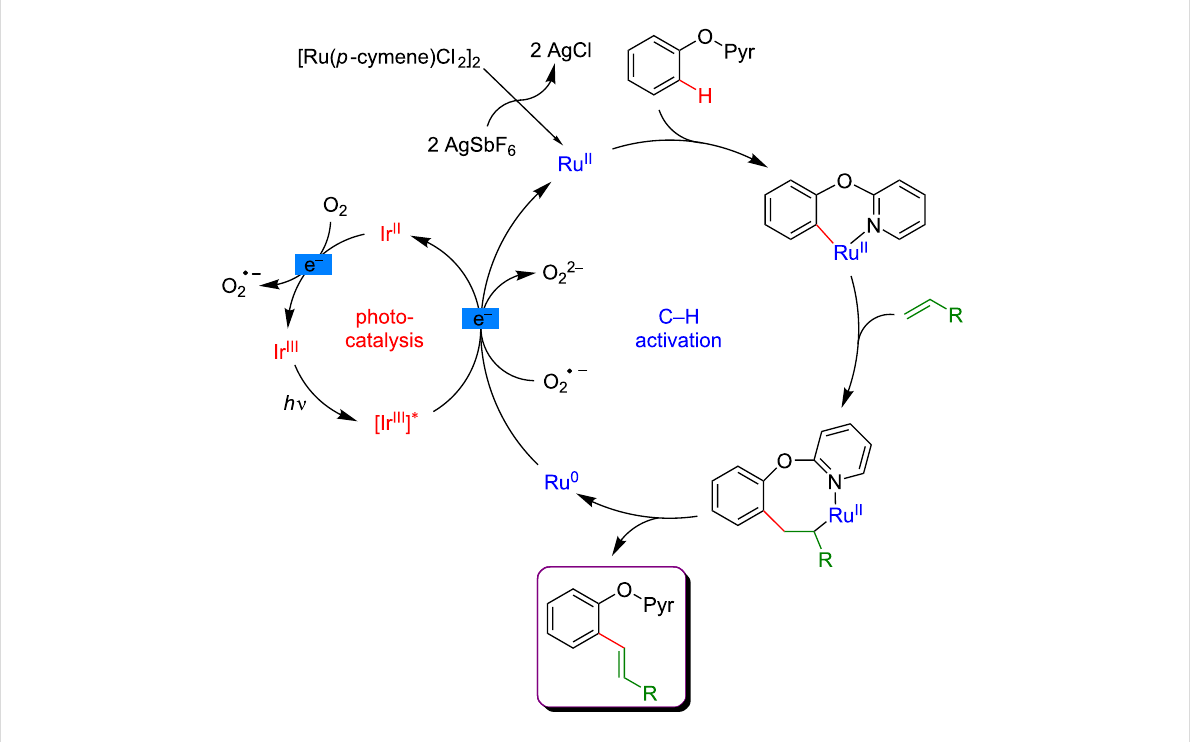
Figure 10: Proposed mechanism for the Heck reaction on phenols via dual catalysis.